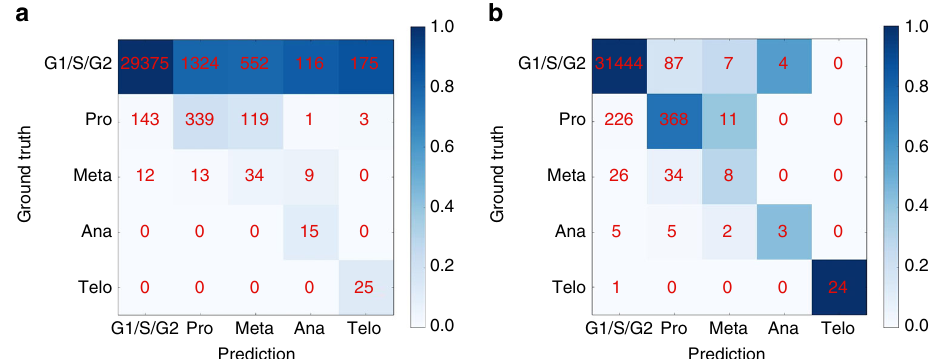
Fig. 5 Confusion matrices for boosting and deep learning for classi fi cation of fi ve classes. To compare with previous work 5 , the three interphase phases (G1, S, G2) are treated as a single class. Red numbers denote absolute numbers of cells in each entry of the confusion matrix, that is, diagonal elements correspond to precision. Coloring of the matrix is obtained by normalizing absolute numbers to column sums. a Boosting 5 , which leads to 92.35% accuracy. b Deep learning, which leads to 98.73% ± 0.16%